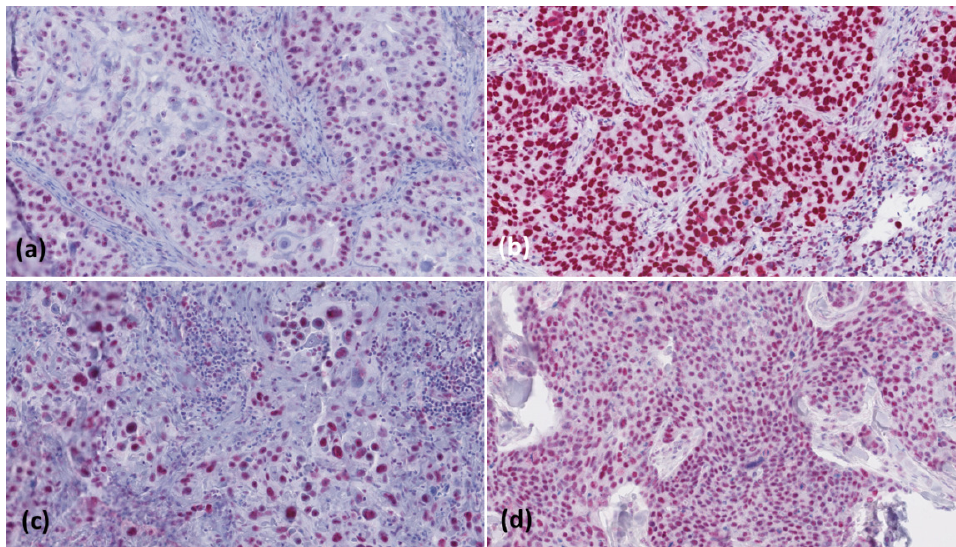
Figure 1. Showing immunohistology images (magnification: ×200) with high-level ( ≥ 50%) nuclear expression of mismatch repair proteins; MSH2 ( a , cSCC > 6 mm), MSH6 ( b , cSCC > 6 mm), MLH1 ( c , cSCC < 2 mm), and PMS2 ( d , cSCC-M). Low-level MMR protein expression was observed in five (102/4.9%) patients (Figure 2), one with cSCC < 2 mm (MLH1 expression: 0.22%), three patients with cSCC > 6 mm (including one with low-level MSH2 (expression: 0.59%) as well as MSH6 (expression: 43.7%) and two with low-level PMS2 (expression: 2.3% and 0.4%)), and one patient with cSCC-M showing low-level MSH2 (expression: 0.64%) as well as MSH6 (expression: 12.1%), (Table 2). Table 2. Description of five cutaneous squamous cell carcinoma cases with low-level * mismatch repair protein expression (<50%).